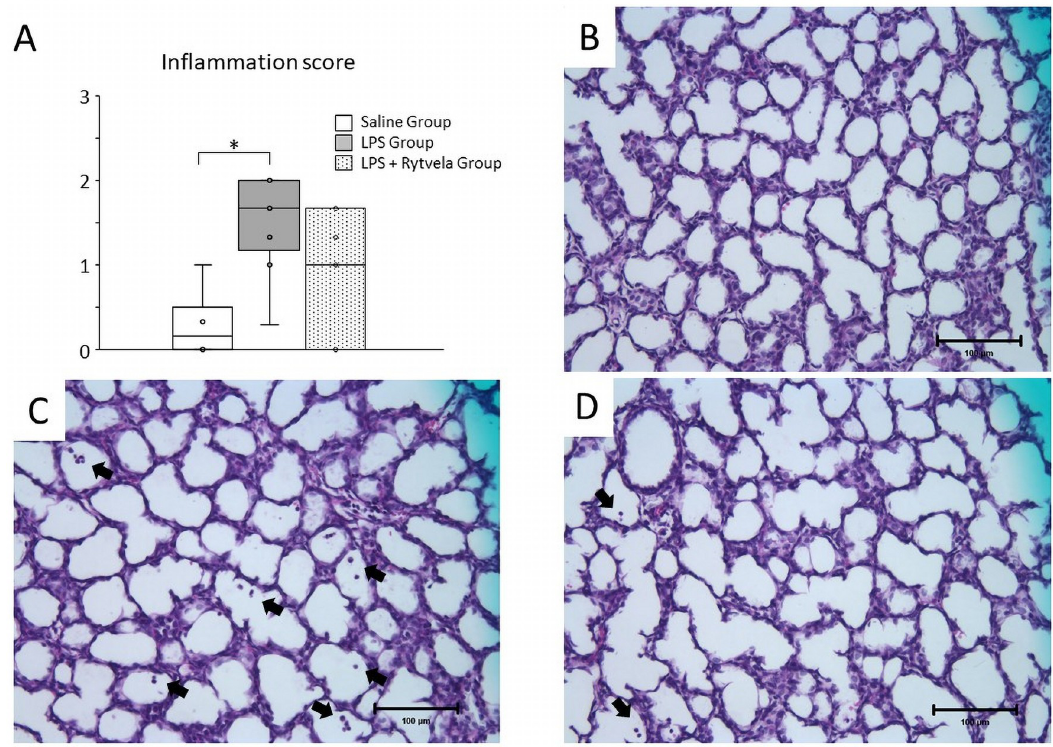
Fig 6. Messenger RNA expression in at delivery. Relative expression of mRNA transcripts for IL-1 β , IL-6, MCP-1, and TNF- α in A , fetal lung; B , skin; C , colon; D , chorioamnion; E , cortex. † p < .05 vs the Saline Group. � p < .05 between the LPS Group and the LPS + rytvela Group. Plots show median, 25th, and 75th percentile ranges as boxes and 5th to 95th percentile as error bars. n = 7–10 animals/group. IL, Interleukin; MCP, monocyte chemoattractant protein; TNF, tumor necrosis factor.